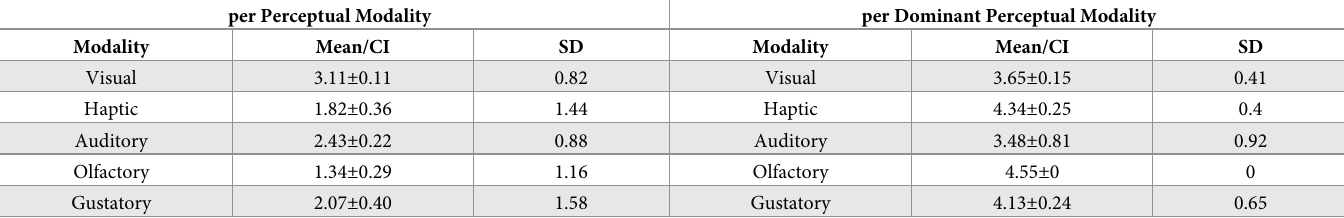
Table 6. Mean strength ratings (0–5) for the disyllabic words, 95% confidence intervals, and standard deviations per perceptual modality and per dominant percep- tual modality.